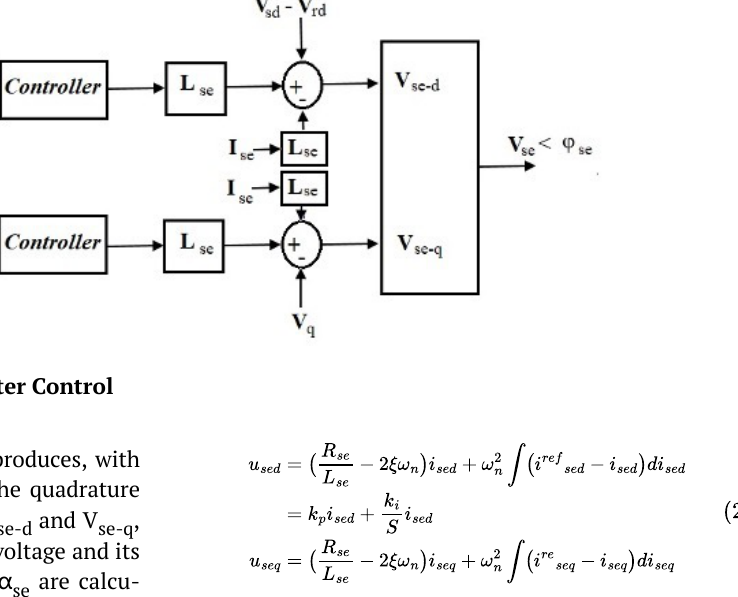
and V , se-d se-q are calcu- se